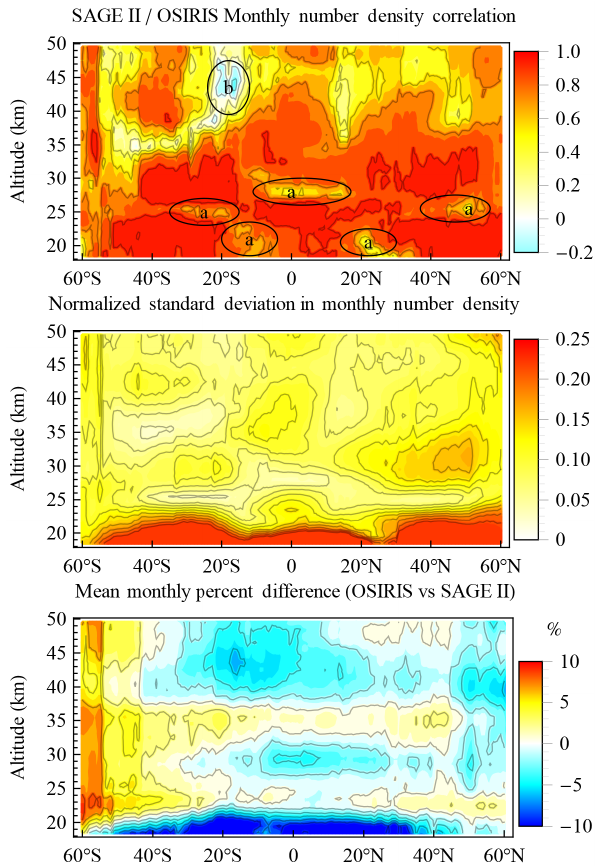
Figure 2. Top: correlation between SAGE II and OSIRIS monthly mean during the overlap period 2002–2005. Middle: standard de- viation of the time series, including measurements from both in- struments during the overlap period, normalized to the monthly mean. Bottom: percent difference between the SAGE II and OSIRIS monthly mean over the same period. Encircled regions marked “a” and “b” denote decreased correlation due to lower amplitude sea- sonal and QBO